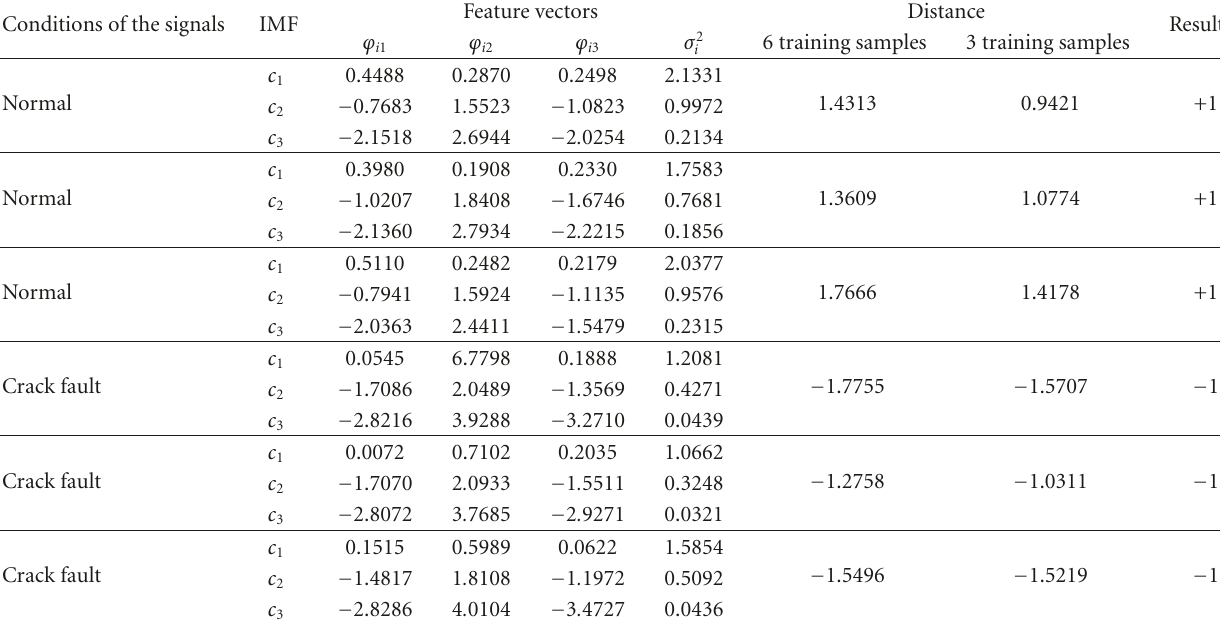
Table 1: The identification results based on IMF AR model and